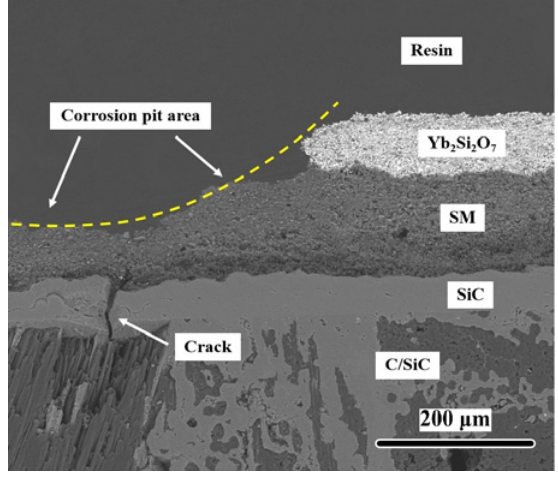
Fig. 12 Cross-section microstructure of tri-layer Yb 2 Si 2 O 7 /SM/SiC coating-coated C f /SiC samples after 540-min corrosion in the burner rig test at 1673